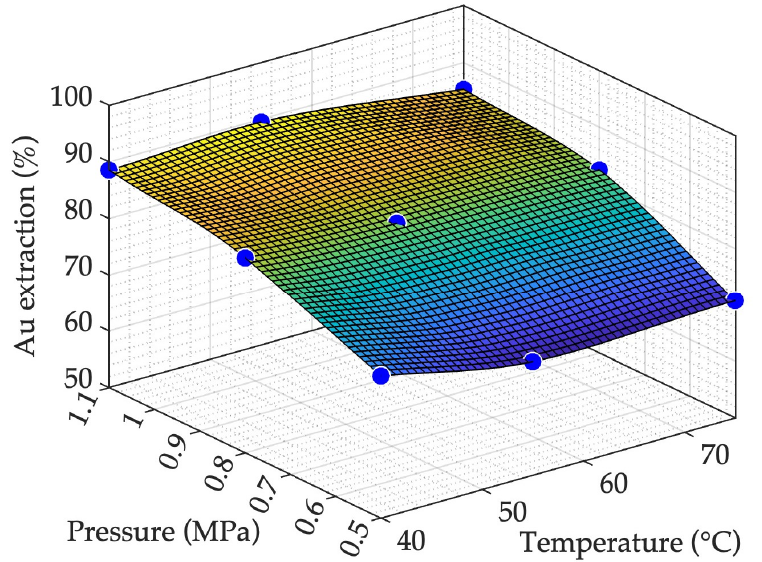
Figure 4. Effects of temperature and pressure on Au extraction at 6 g/L cyanide concentration.